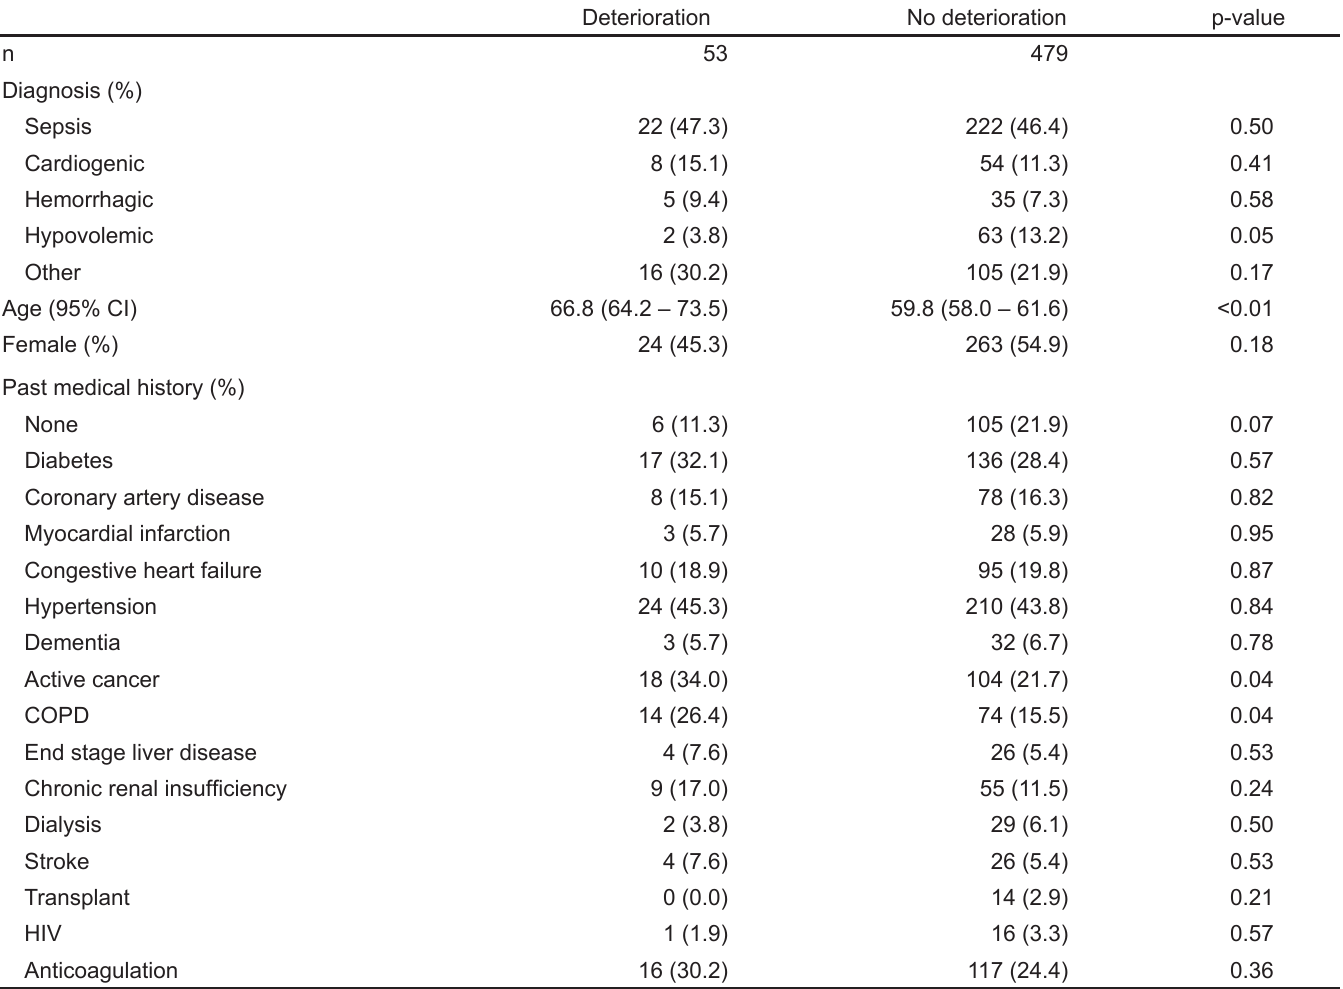
Table 2. Patient demographics and underlying diagnosis. Factors with p<0.1 were included as candidate variables in the multiple re- gression